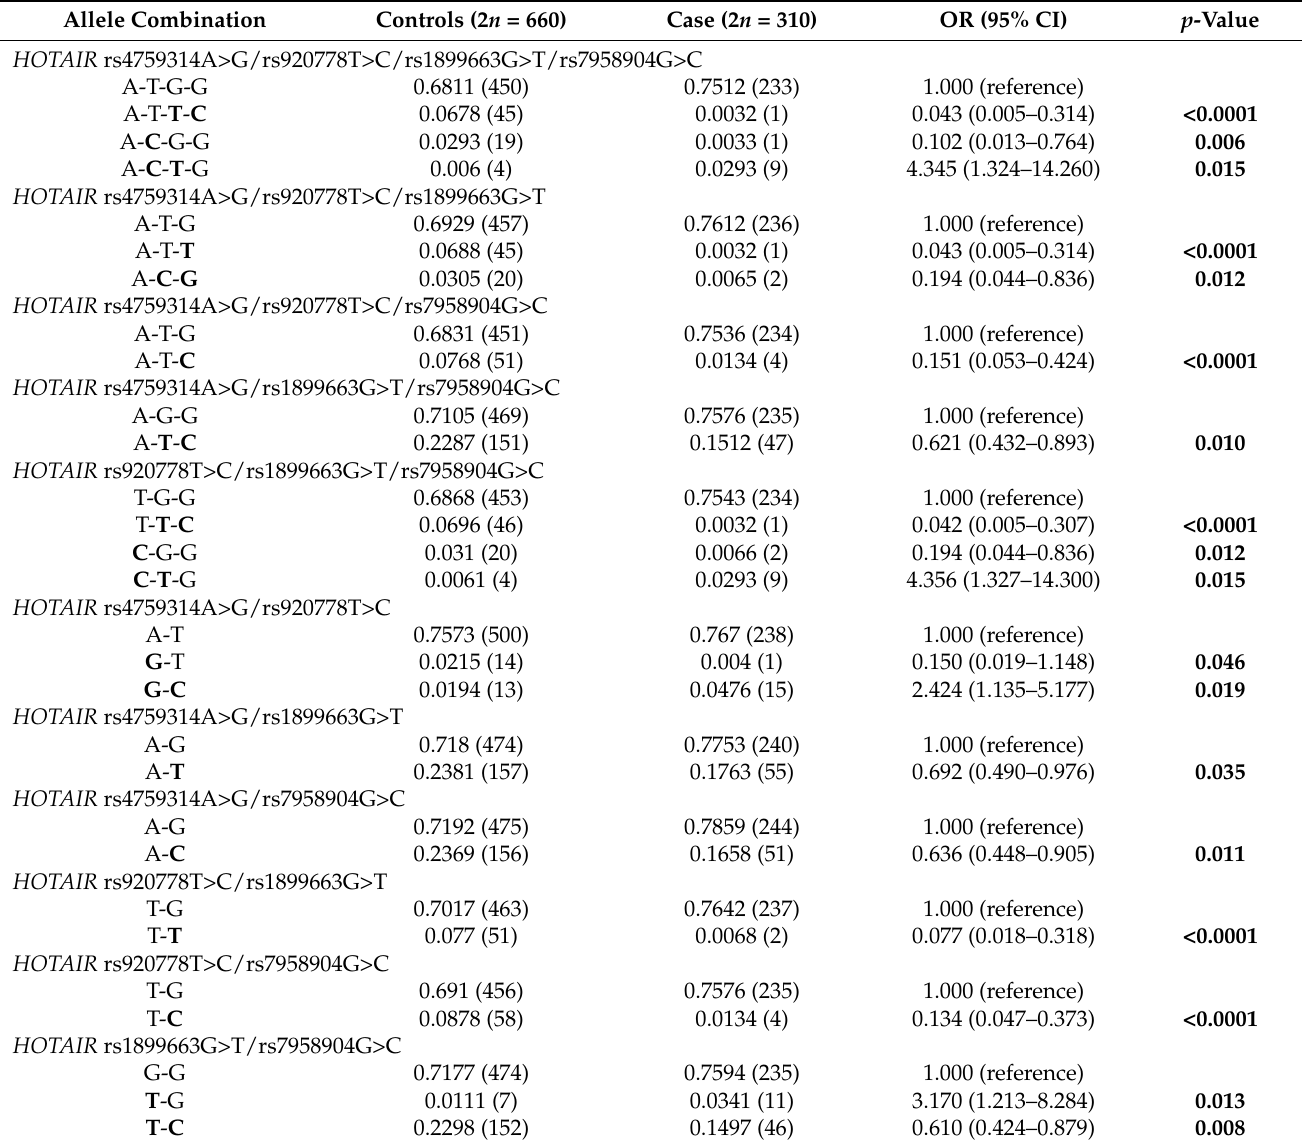
Table 4. Allele combination analysis for the four evaluated polymorphisms in RIF patients and controls